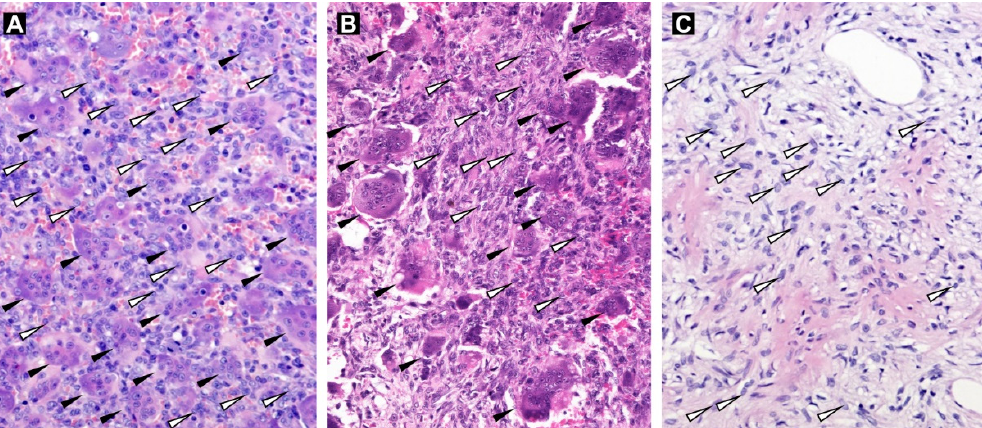
Figure 1. Hematoxylin-eosin-stained tissue sections of GCTB samples. Tumor tissue without denosumab treatment (Sample No. 4; A ) and tissue of a relapsed sample (Sample No. 1; B ) with osteoclast-like multinucleated giant cells (black arrowheads) and mononuclear stromal cells (white arrowheads; examples only). GCTB sample after denosumab treatment without the presence of osteoclast-like giant cells (Sample No. 3; C ). Original magnification, 200×.